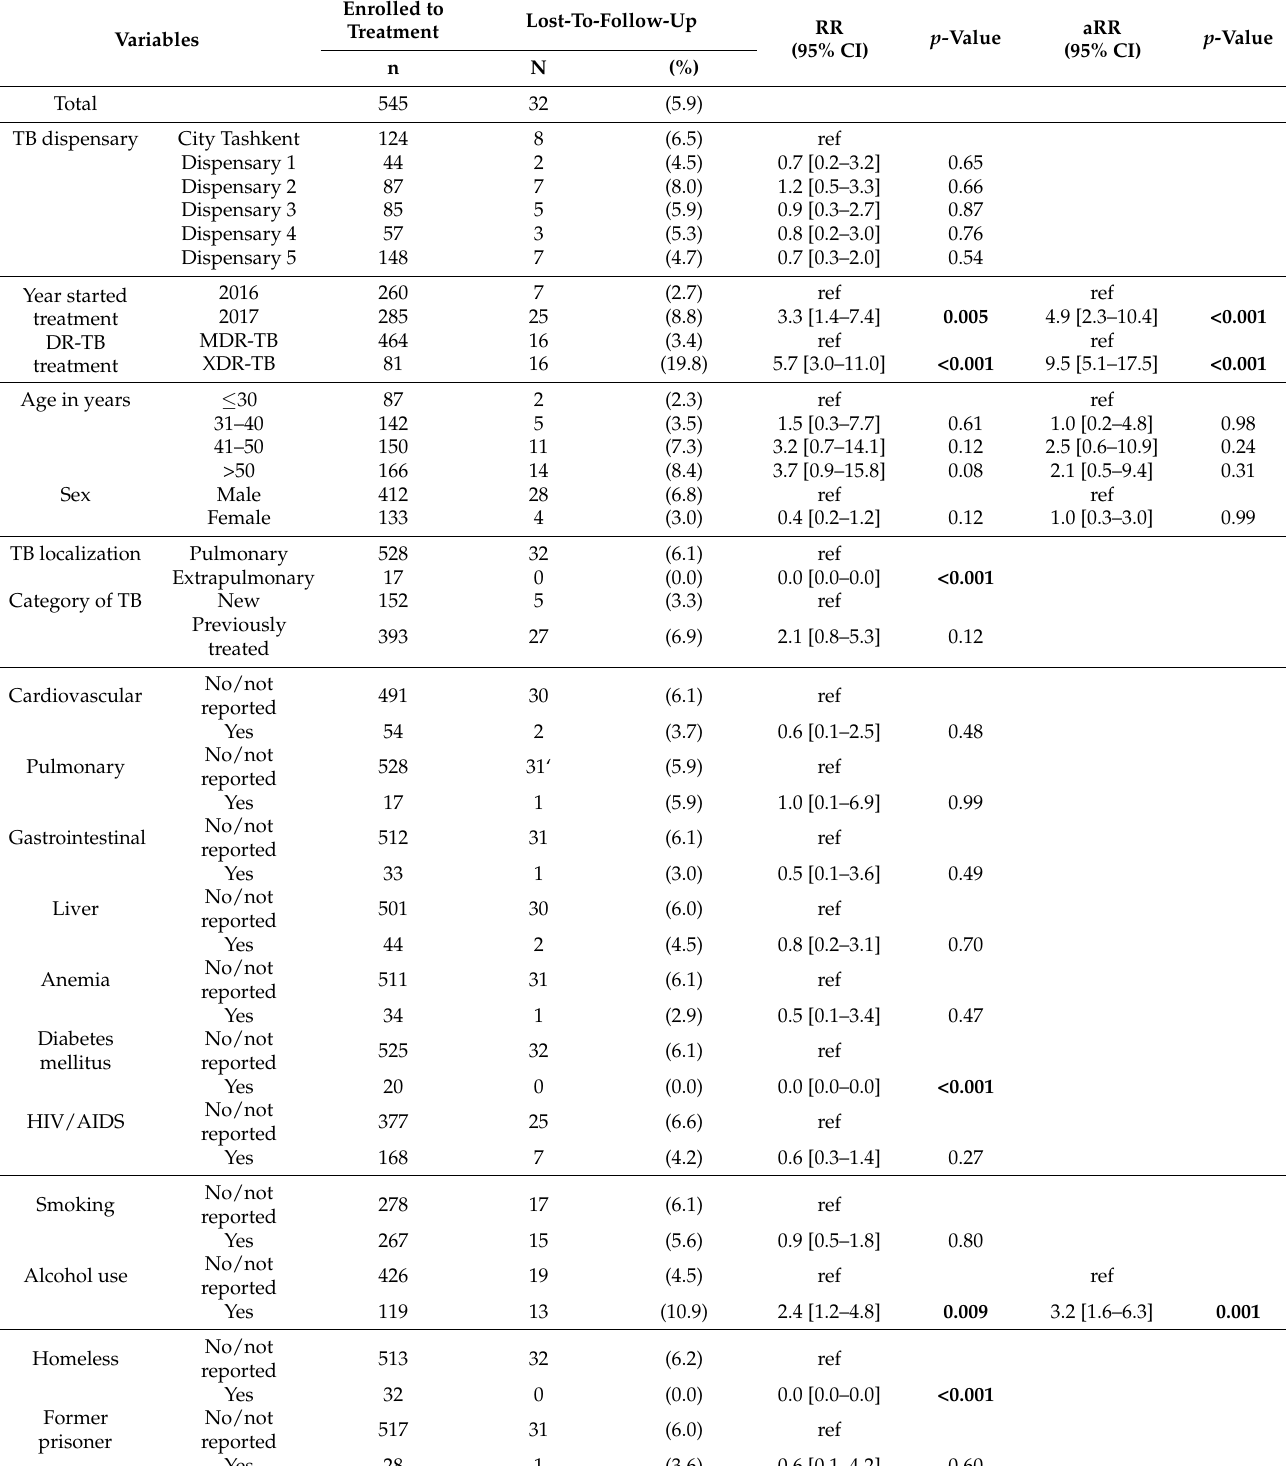
Table 5. Risk factors for loss to follow-up in patients with TB enrolled for MDR-TB and XDR-TB treatment in Tashkent city, Uzbekistan,